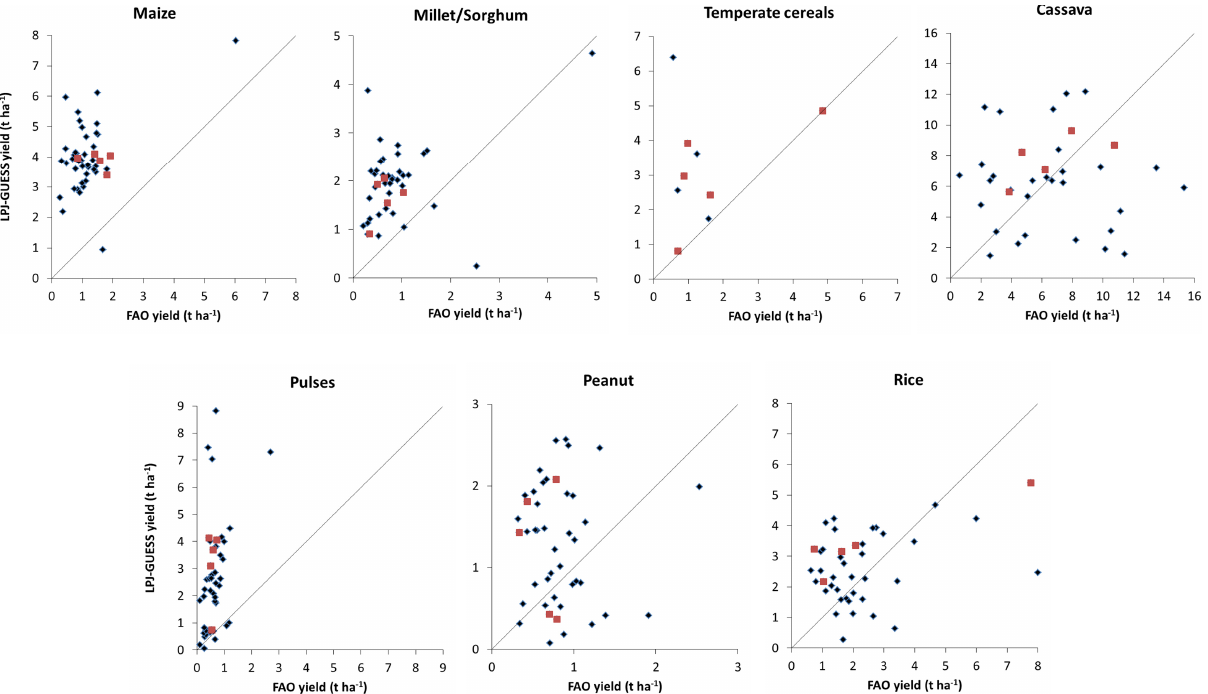
Fig. 8. Scatter plots of LPJ-GUESS modelled yield versus FAO reported yield of the seven most widespread crops in Africa (1991–1995 country means). The five countries with the largest area of each crop are indicated in red. Countries where temperate cereals could not grow because of the upper temperature limit are excluded from the scatter